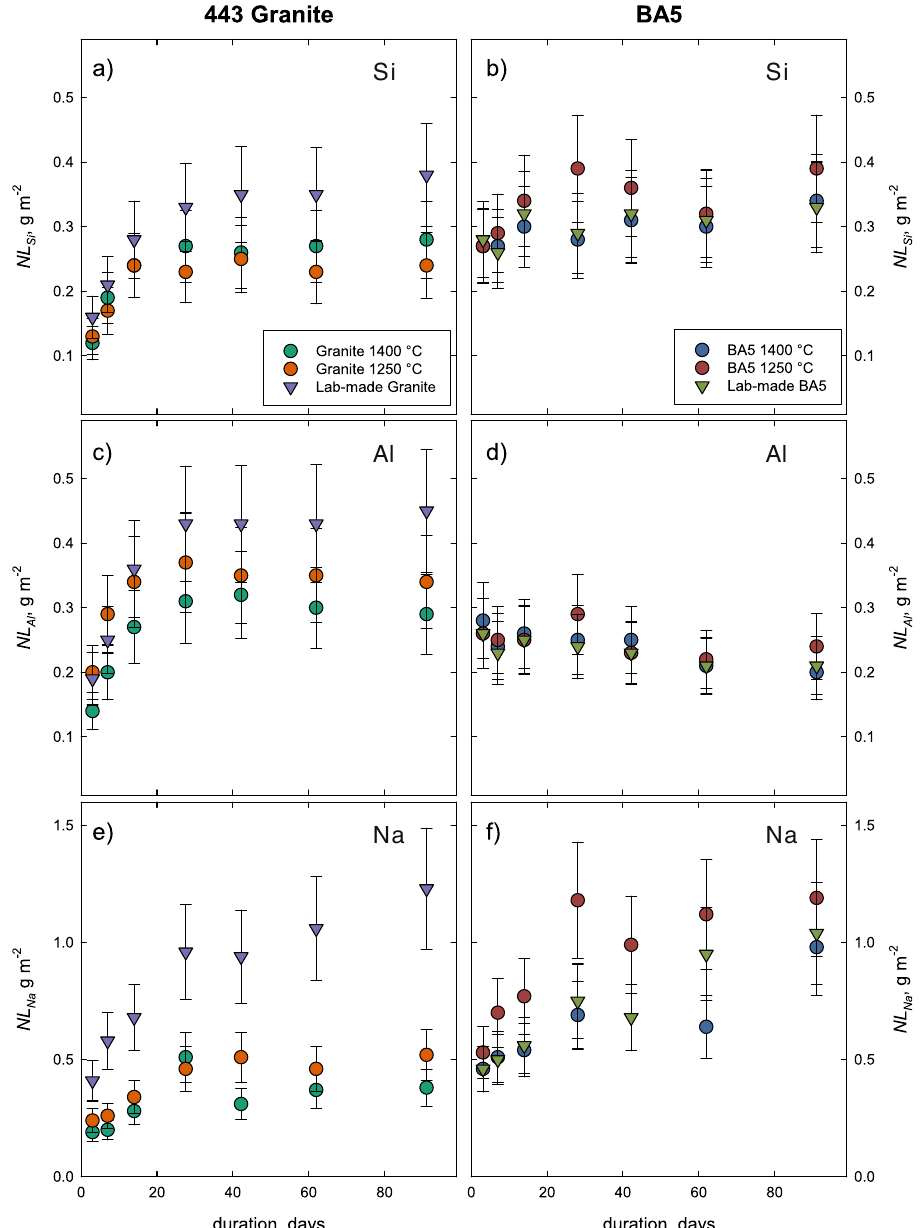
Fig. 3 The normalized mass loss (NL i ) for 443 Granite and BA5 samples from modi fi ed PCT-B conducted at 90 °C and 200 m − 1 . NL Si , NL Al , and NL Na are plotted in ( a , c , e ) and ( b , d , f ) for Granite 443 and BA5, respectively. The y -axis for the Na data ( e , f ) is plotted on a different scale than Si ( a , b ) and Al ( c , d ). The uncertainty displayed in the plots is 21% of the value of NL i was calculated with Eq.